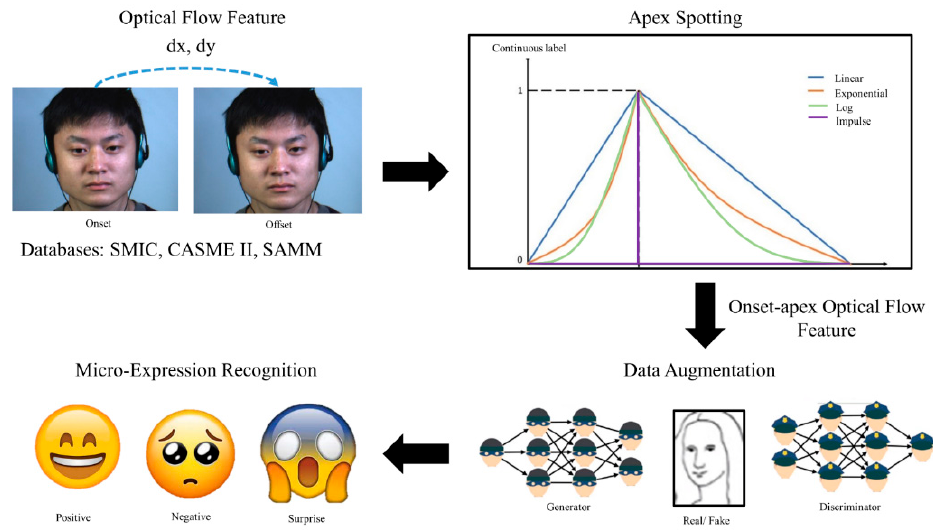
Figure 5. Workflow of the proposed method.